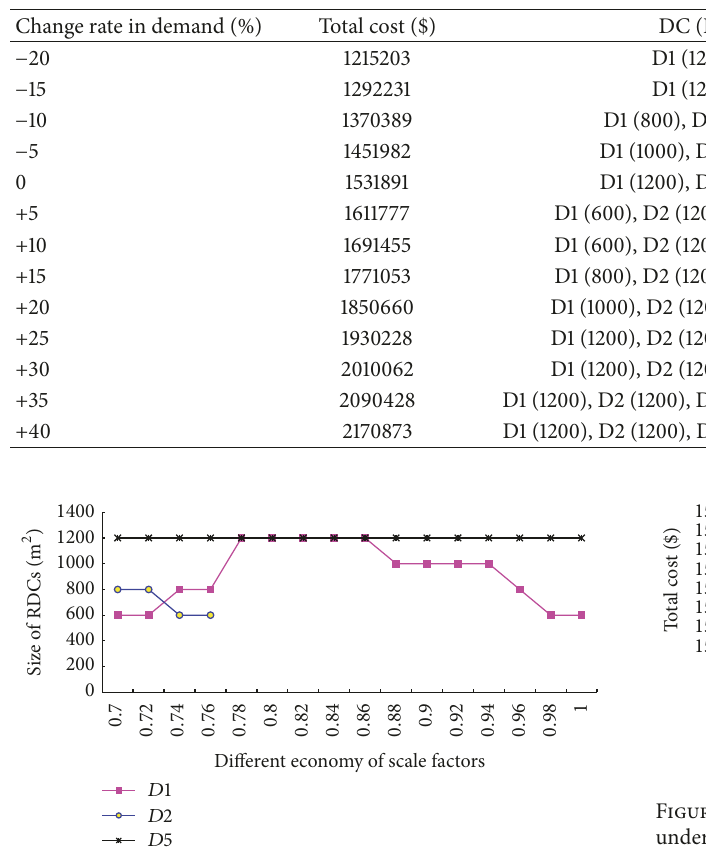
Figure 4: Optimal size of RDCs under different values of economies of scale parameter 𝜃 .